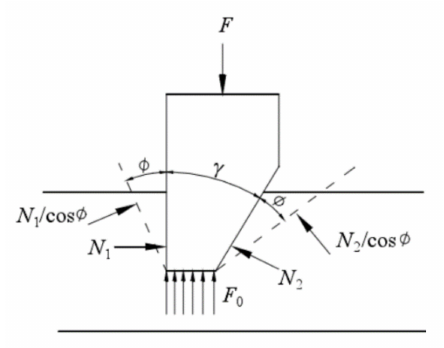
Figure 10. Force analysis of tool cutting